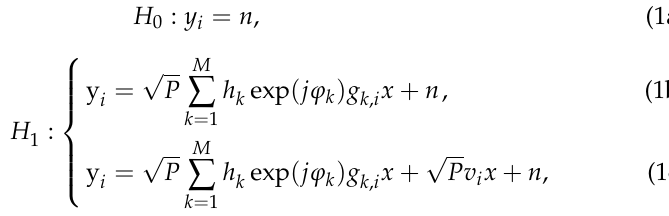
(cid:17) (cid:16)(cid:113) (cid:12) (cid:12) (cid:0)(cid:112) (cid:1) β h β g , i , , (cid:12) g k , i (cid:12) ∼ Rayleigh